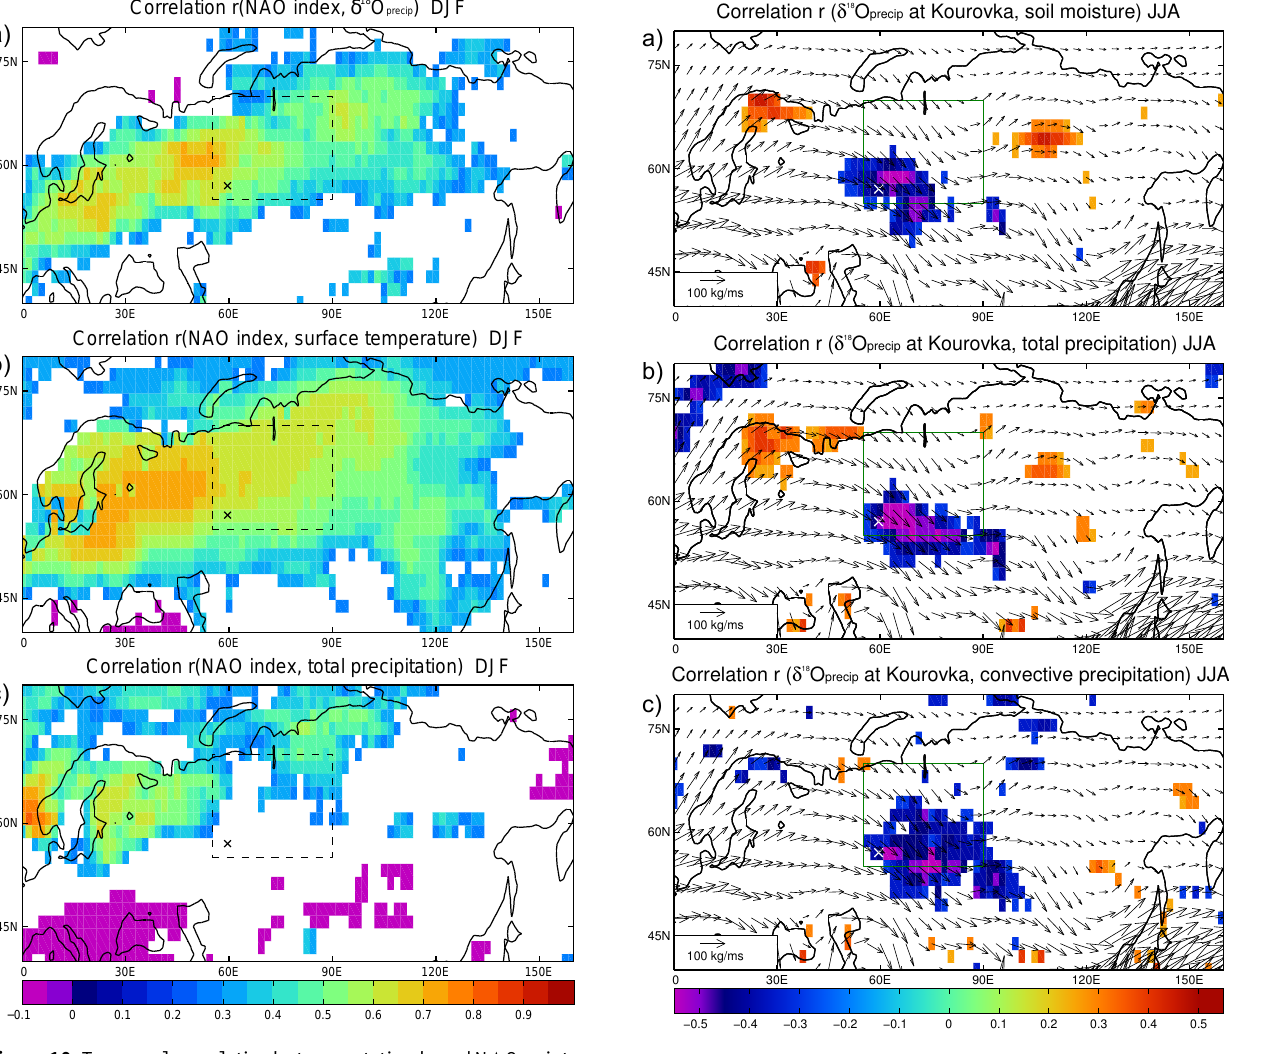
Figure 11. One-point correlation map showing the correlation be- tween δ 18 O in precipitation at Kourovka during summer (JJA) with (a) soil moisture, (b) total precipitation, and (c) convective pre- cipitation. Also shown is the average atmospheric moisture trans- port during JJA (vectors; only every second vector is drawn). The green box indicates western Siberia and the position of Kourovka is marked by a white cross. The correlation period is 1960–2010. Sta- tistically insignificant areas (where p ≥ 0.05 applying a t test) are blanked. See also Table 3 for